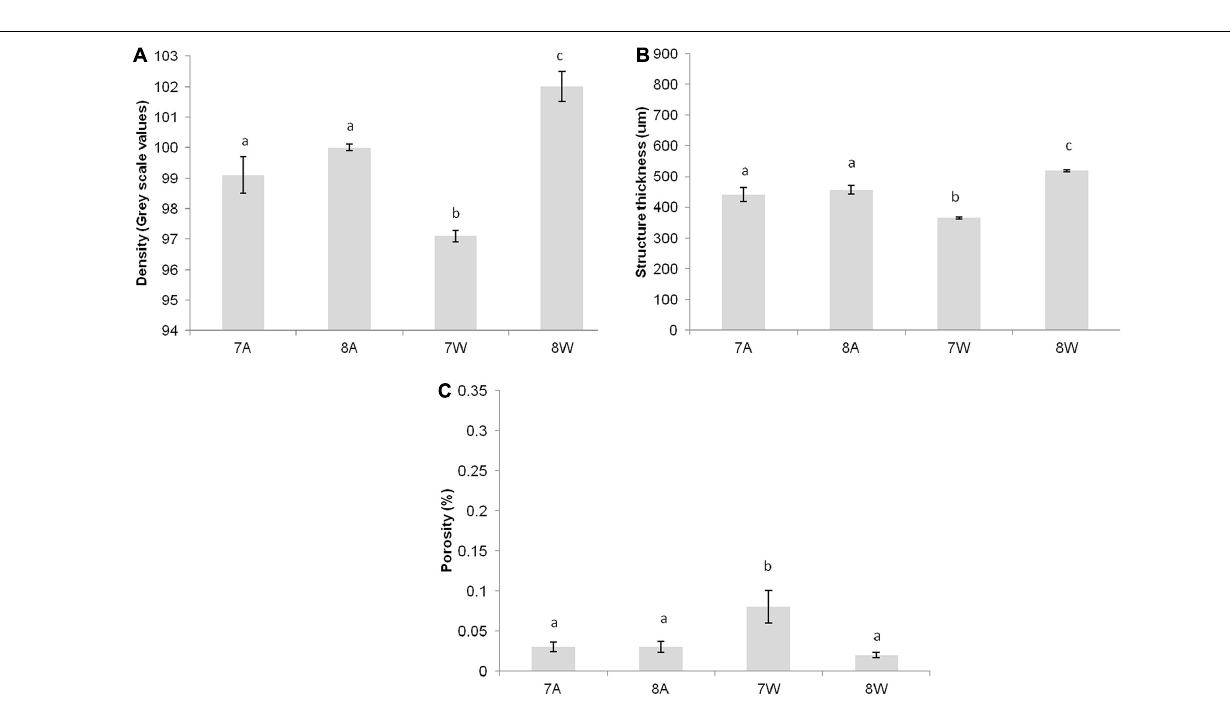
FIGURE 2 | (A) Mean density (gray scale values) of total shell. (B) Mean structure thickness of total shell. (C) Shell closed porosity (%) for Collumbela rustica . The horizontal axis presents the four different experimental treatments as coded in the text (8A: 20 ◦ C and pH = 8; 7A: 20 ◦ C and pH = 7.7; 8W: 23 ◦ C and pH = 8; 7W: 23 ◦ C and pH = 7.7). Error bars represent ± SE (i.e., variation among individuals). N = 9 C. rustica per